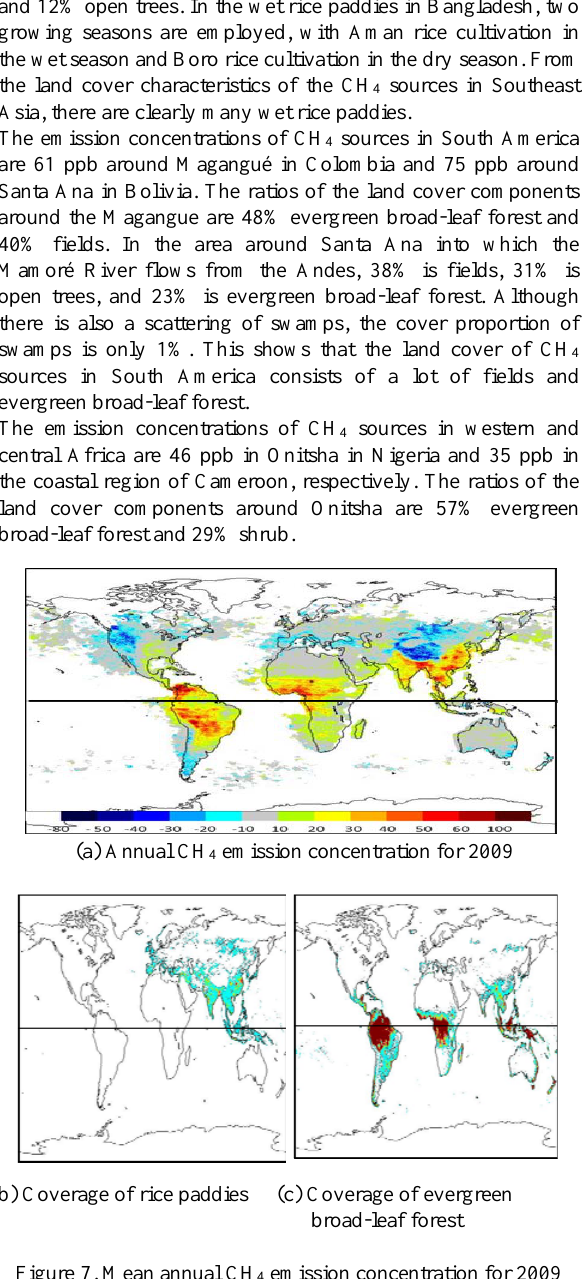
Figure 7. Mean annual CH 4 emission concentration for 2009 and land cover coverage of rice paddies and evergreen broad- leaf